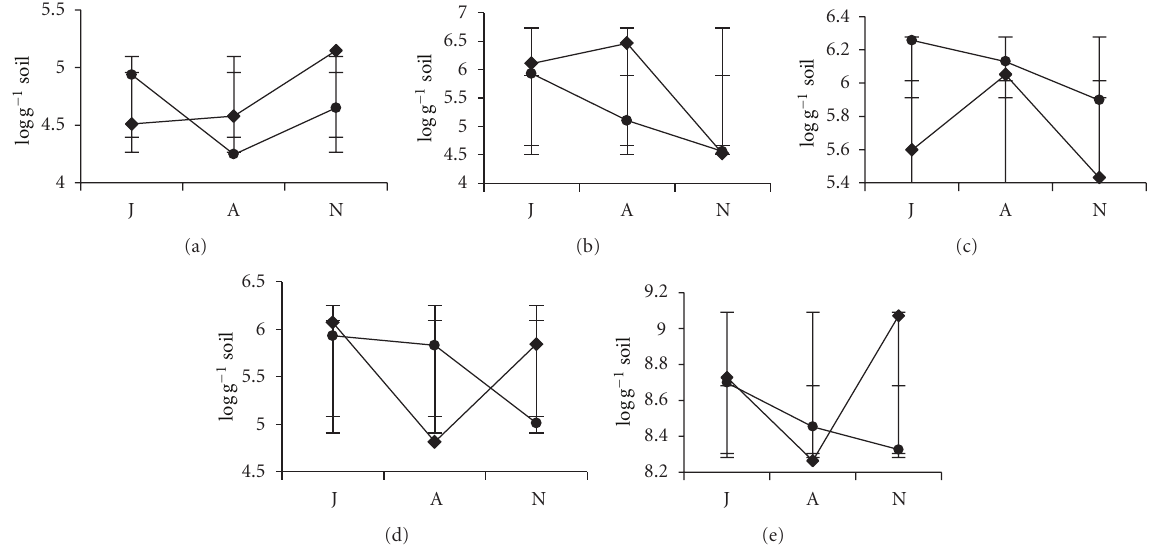
Figure 3: Microbe numbers on a logarithmic scale displaying di ff erent responses to monoculture (M) and rotation (R) in in the di ff erent seasons (J = July; A = August; N = November) in 2006. Monoculture = M - (cid:2) -; rotation = R - • -. (a) Filamentous hymenomycetes, (b) nonfilamentous hymenomycetes, (c) actinomycetes, (d) protozoa, and (e) heterotrophic counts. Vertical bars denote standard deviation.